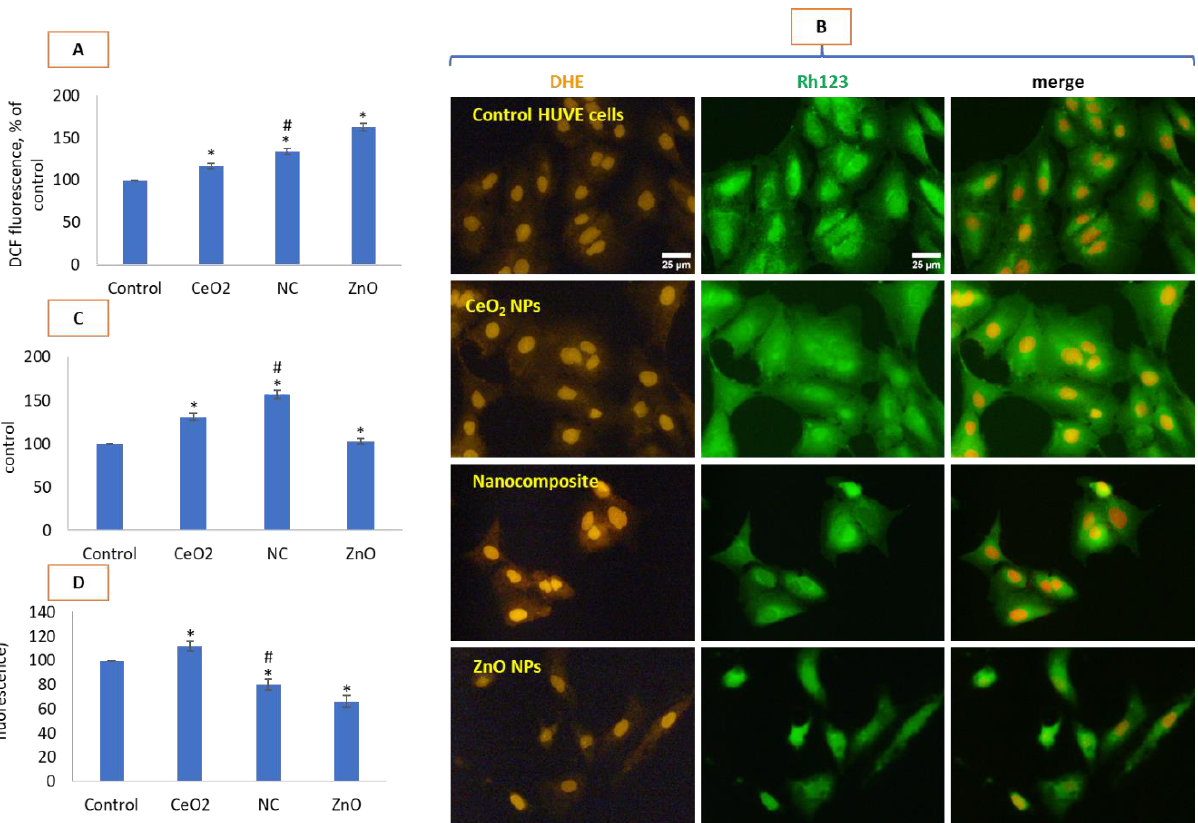
Figure 4. Potential generation of ROS in HUVEC cells due to various NP treatments was evaluated by DCFH-DA ( A ), DHE imaging (red images in B ) and its fluorescence quantification ( C ). MMP was determined by Rh123 imaging (green images in B ) and its fluorescence quantification ( D ). Merge refers to the images obtained after color merging of DHE and Rh123 images in ImageJ. Scale bar represents 25 µm and was provided only in the control images. Each image was captured by a 40× objective under uniform conditions of illumination intensity, time and other variables. Each exper- iment was performed in triplicates ( n = 3). *statistically significant difference from the control ( p < 0.05). # statistically significant difference in between treatments of CeO 2 -Zn nanocomposite and ZnO NP ( p < 0.05).